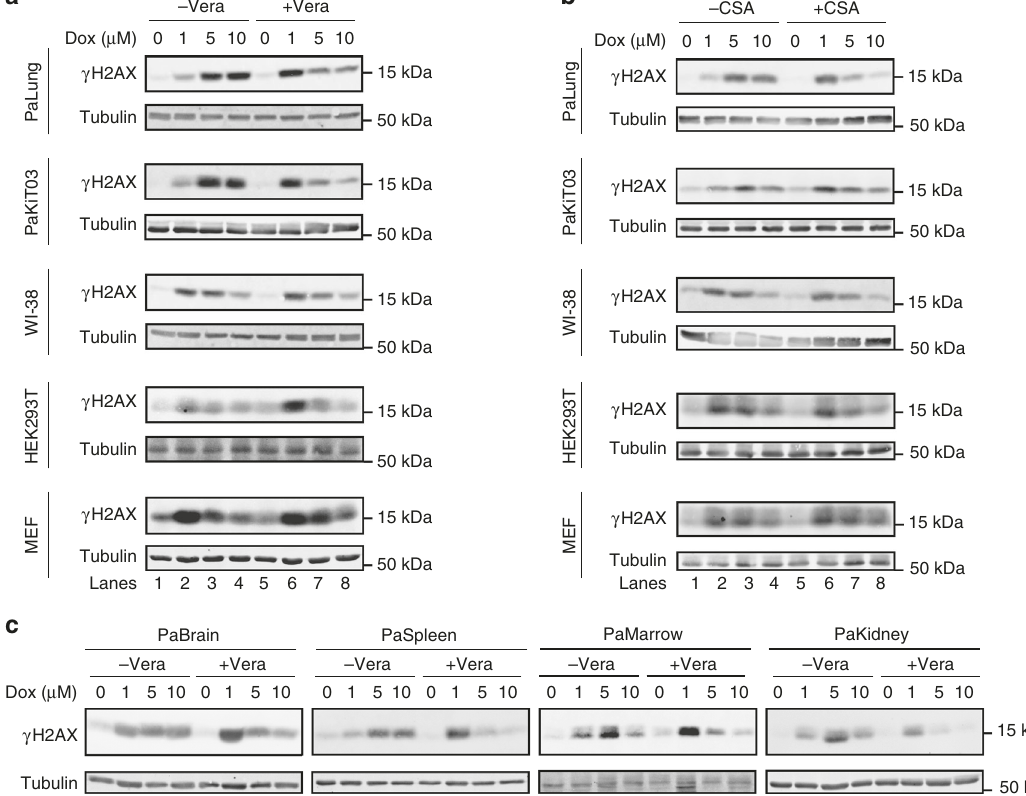
Fig. 4 Effect of ABC transporter inhibition on γ H2AX induced by doxorubicin. a , b Western blot analyses of γ H2AX induced by increasing doses of doxorubicin (Dox). PaLung, PaKiT03, WI-38, HEK293T and MEF cells were pre-treated without or with 5 µ M verapamil (Vera) ( a ) or 5 µ M cyclosporin A (CSA) ( b ) for 30 min before the treatment with the increasing amount of DOX alone or together with Vera or CSA for additional 3 h. c Cells derived from different tissues of P. alecto were treated as in ( a ) and analysed by Western blotting. All results are representative of at least three experimental repeats. Tubulin was used as a loading